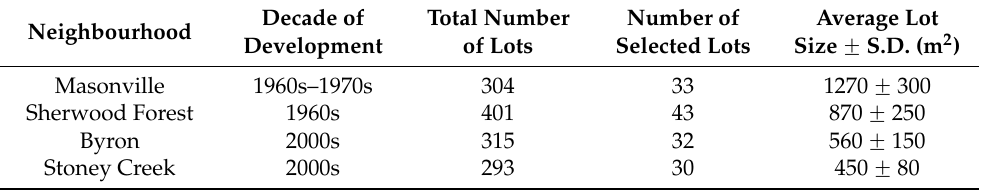
Figure 3. Neighbourhood extents and randomly selected private properties for Stoney Creek, London ( 1 ) and Millview, Halifax ( 2 ). Table 2. Neighbourhoods examined in London.